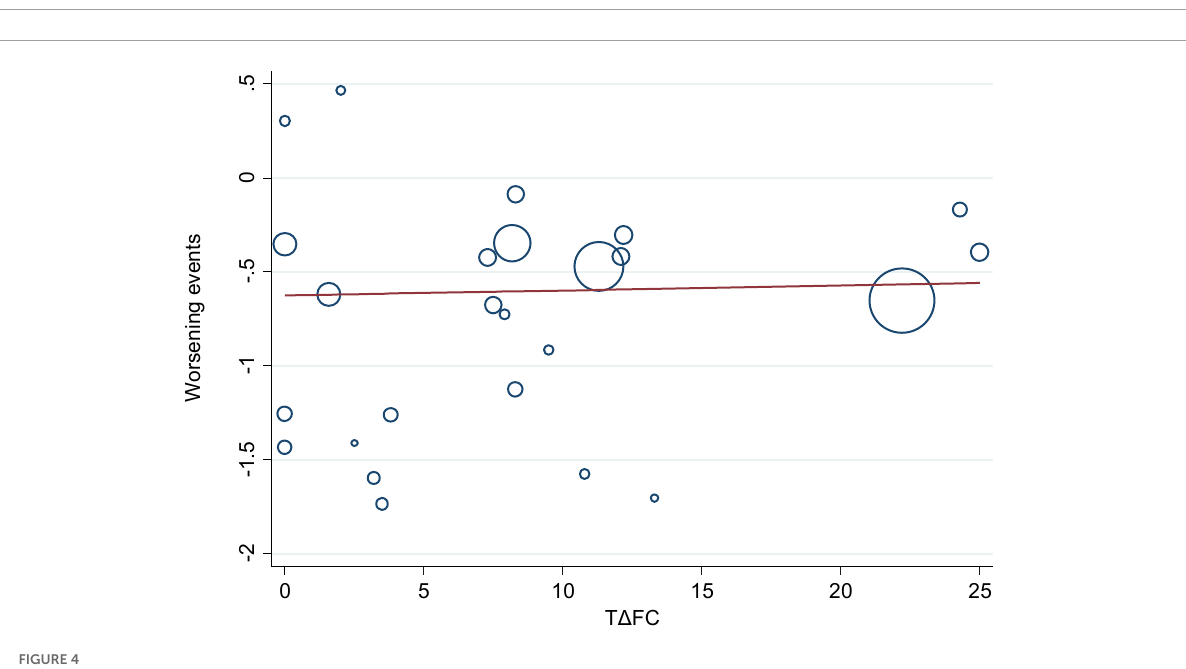
FIGURE3 Meta-regression analysis of 6-min walk distance from baseline ( (cid:49) 6MWD) and clinical worsening events (CWEs).